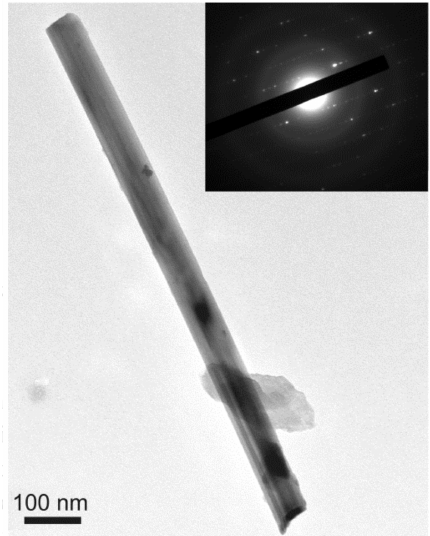
Figure 11. TEM image of amosite and corresponding SAED pattern after 10 min of